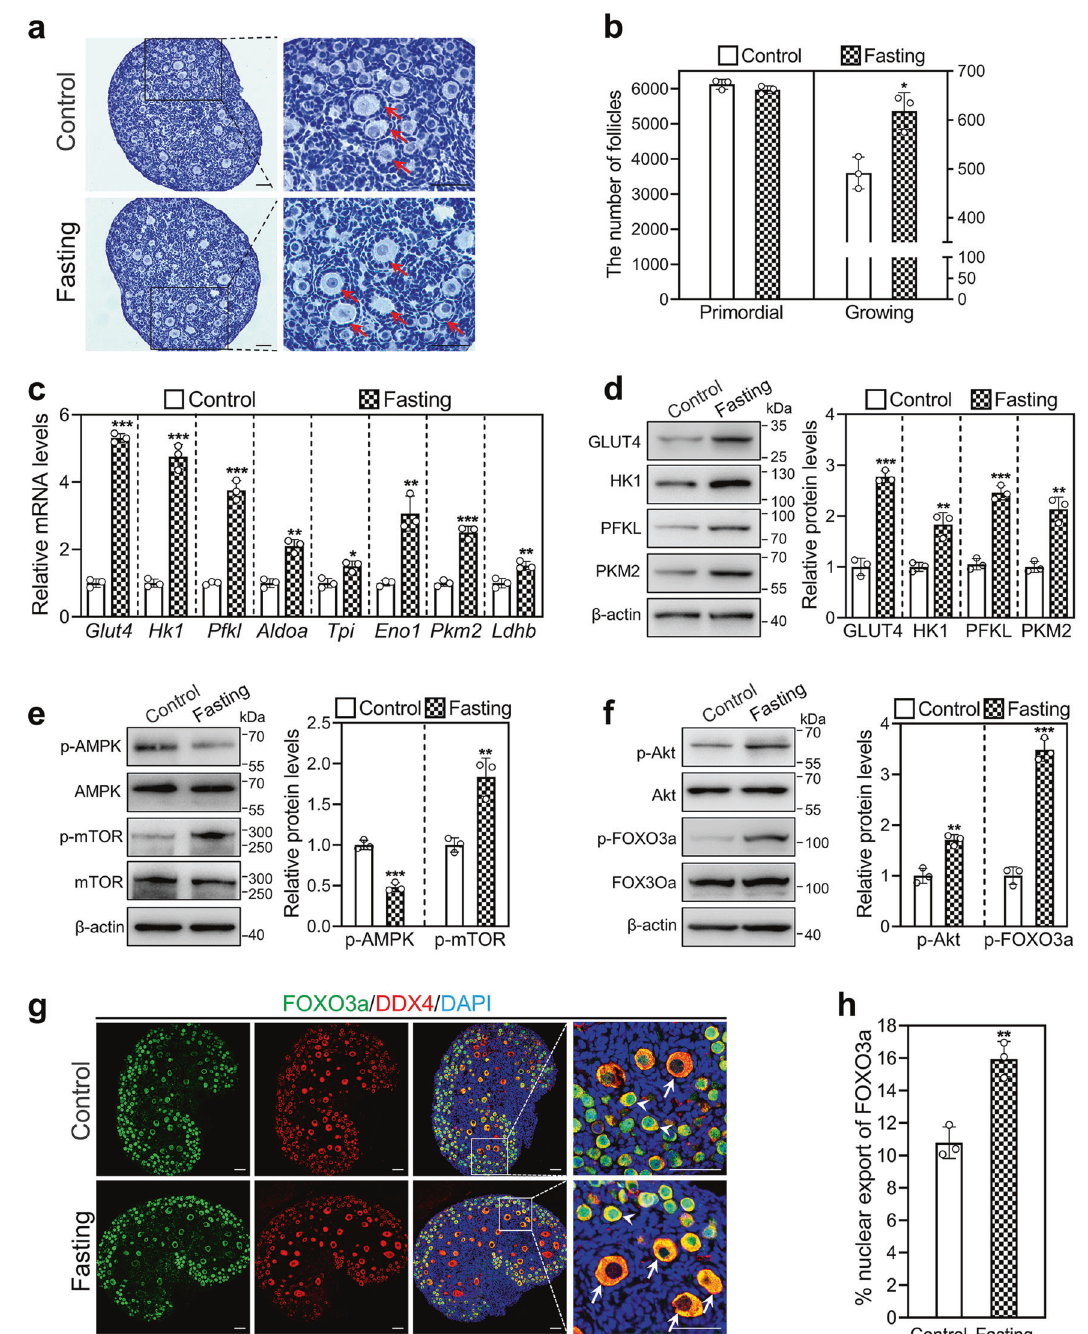
Fig. 5 Effect of acute fasting on glycolysis and mouse primordial follicle activation in vivo. Two-day-old female mice were kept with their mother (control), or were separated from their mother for 18 h and then returned to their mother (acute fasting). The ovaries were collected at 24 h ( c – f ) and 48 h ( a , b , g , h ) of treatment, respectively. a , b Morphological comparison of the ovaries ( a ) and the number of primordial and growing follicles (arrows, b ) in the control and acute fasting group. Nuclei were stained by hematoxylin. Scale bars: 50 μ m. c The mRNA levels of Glut4 , Hk1 , Pfkl , Aldoa , Eno1 , Tpi , Pkm2 , and Ldhb in the control and acute fasting group. d The protein levels of GLUT4, HK1, PFKL, and PKM2 in the control and acute fasting group. e , f The protein levels of p-AMPK, p-mTOR ( e ), p-Akt, and p-FOXO3a ( f ) in the control and acute fasting group. g , h The localization of FOXO3a in oocyte nuclear (arrowheads) and cytoplasm (arrows, g ) and the percentage of oocytes with FOXO3a nuclear export ( h ) in each section in the control and acute fasting group. FOXO3a, green; DDX4, red; DAPI, blue. Scale bars: 50 μ m. Fasting, acute fasting. All the experiments were repeated three times, and the representative images are shown. In western blot results, the levels of total AMPK, mTOR, Akt, and FOXO3a were used as the corresponding internal control for p-AMPK, p-mTOR, p-Akt, and p-FOXO3a, respectively, and β -actin was used as the internal control for GLUT4, HK1, PFKL, and PKM2. Bars indicate the mean ± SD. * P < 0.05, ** P < 0.01, and *** P < 0.001 vs. control.